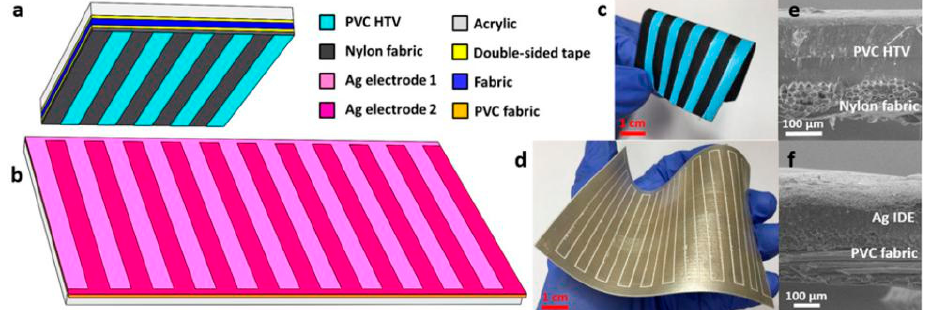
Figure 1. Schematic illustration of ( a ) the upper substrate of pnG-TENG for N = 10 with PVC HTV as negative material and nylon fabric as positive material and ( b ) the lower substrate of pnG-TENG with interdigitated Ag electrodes. Photograph of ( c ) the upper substrate and ( d ) the lower substrate of pnG- TENG without the acrylic sheet. SEM images of ( e ) the upper substrate and ( f ) the lower